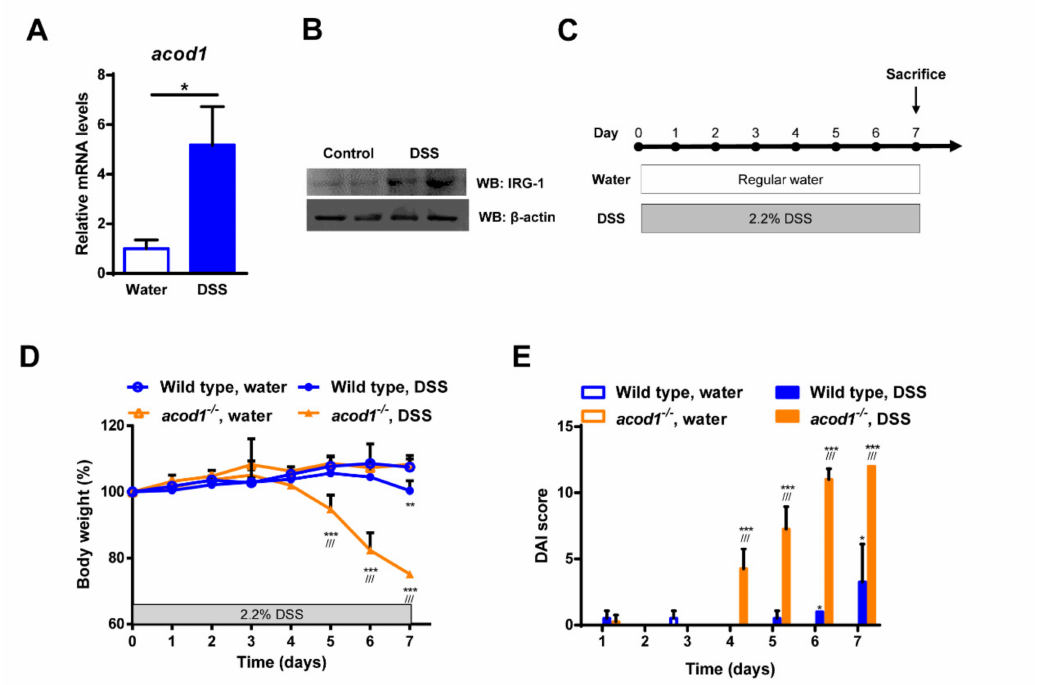
Figure 1. The effects of Acod1 gene deficiency on the clinical features of DSS-induced colitis in C57BL/6 mice. The colonic mRNA ( A ) and protein expression ( B ) levels of Acod1 in WT mice treated with DSS. ( C ) A schematic illustration of the mouse model of DSS-induced colitis. WT and acod1 − / − mice were administered regular water or 2.2% DSS for 7 days. ( D ) Weight changes in WT and acod1 − / − mice within 7 days of treatment with DSS. ( E ) Disease activity index (DAI) scores of WT and acod1 − / − mice after DSS treatment. ( * p < 0.05, ** p < 0.01, and *** p < 0.001 compared with WT. ///p < 0.001 WT + DSS versus acod1 − / − + DSS). ( D ) Colonic mRNA levels of Acod1 in WT mice treated with